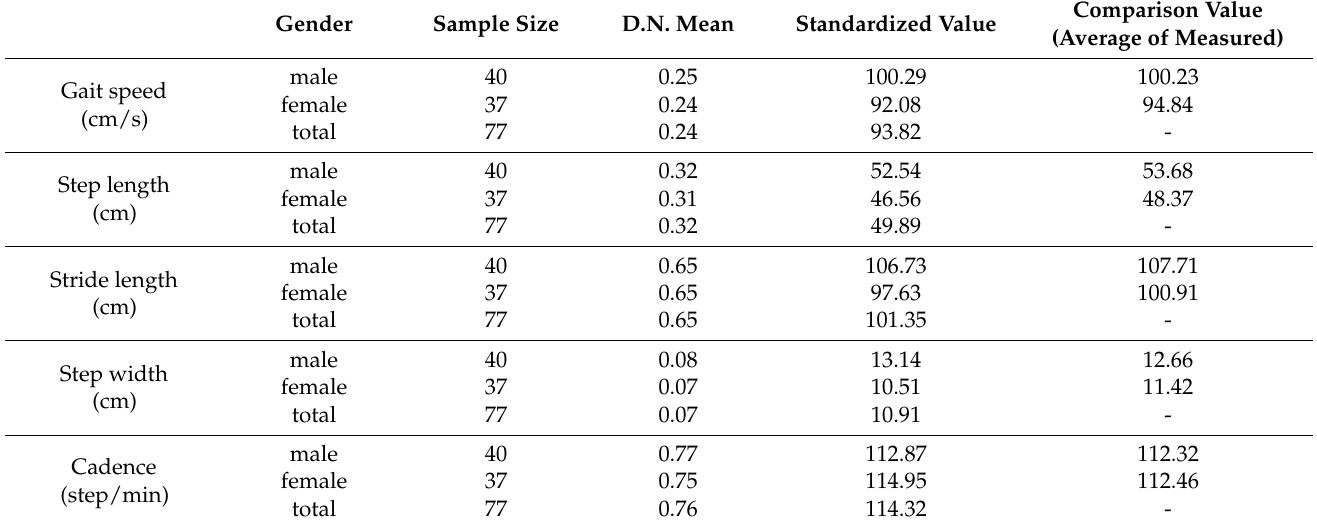
Table 7. Standard gait model of the elderly in South Korea.